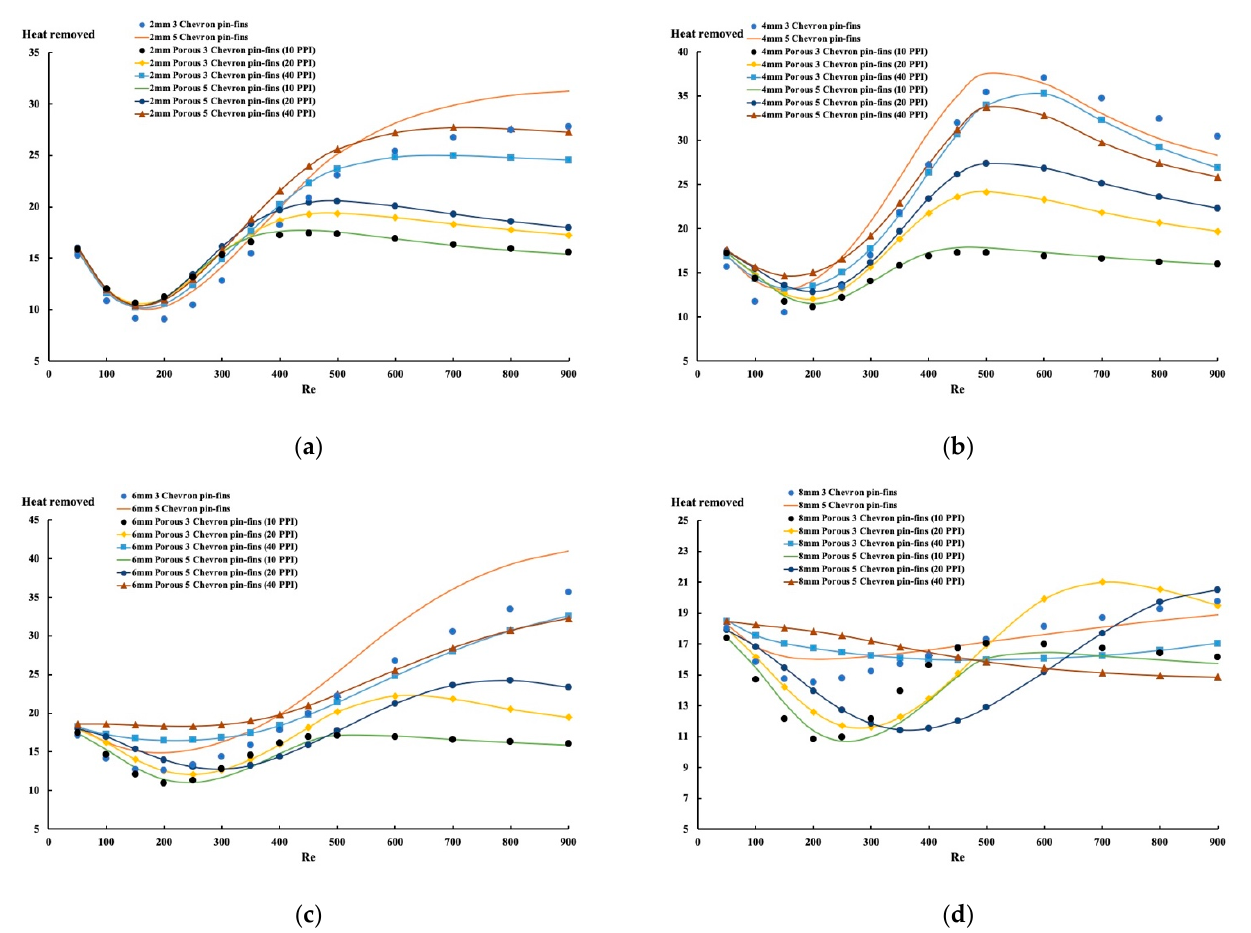
Figure 12. Heat-removed variation for all cases: ( a ) 2 mm pin-fin height; ( b ) 4 mm pin-fin height; ( c ) 6 mm pin-fin height; ( d ) 8 mm pin-fin height.